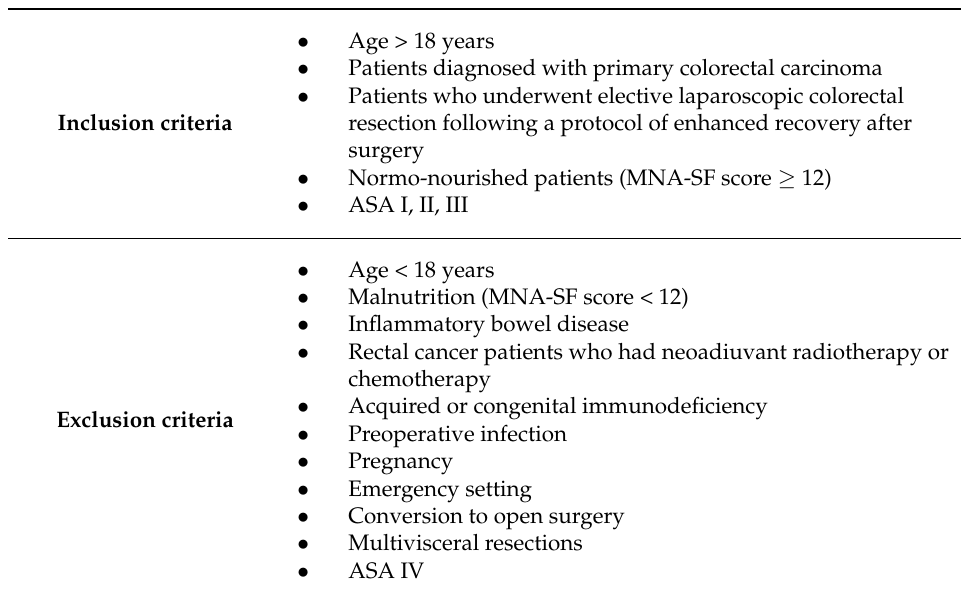
Table 2. Inclusion and exclusion